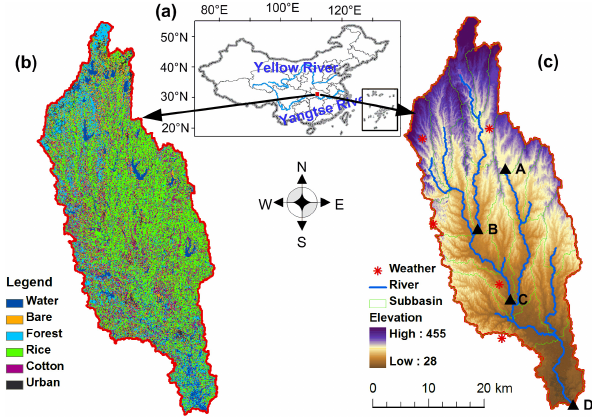
Figure 1. Zhanghe River basin in China (a) , the land use (b) and subbasin distribution with DEM (c)